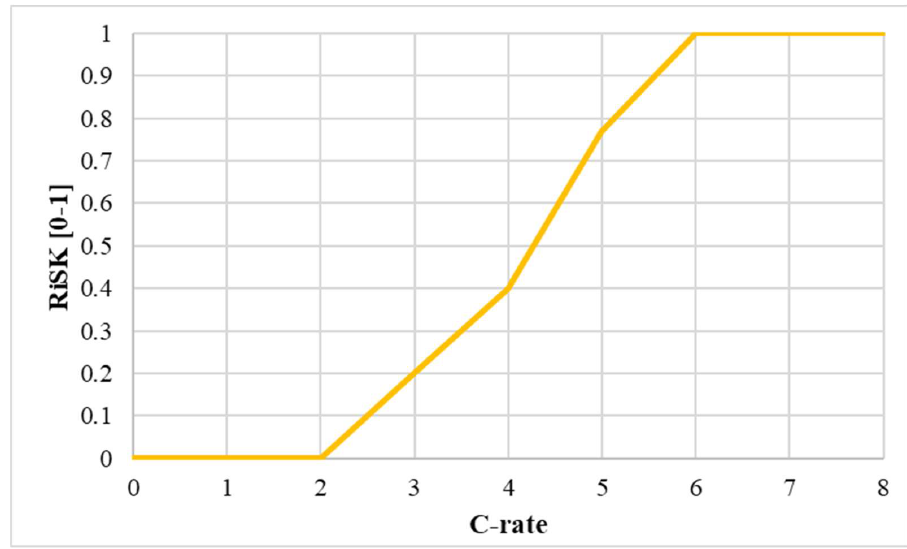
Figure 10. Relationship between risk and C-rate (the meaning of C-rate can be found in Figure